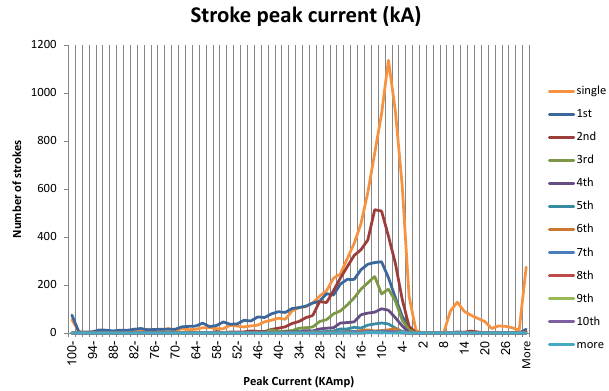
Fig. 7. The distribution of peak current [kA] for single- and multiple-stroke flashes in the 30 October storm. “Single” refers to flashes with one stroke, and the different lines refer to the distribu- tion of peak current as a function of stroke order in events when m ≥